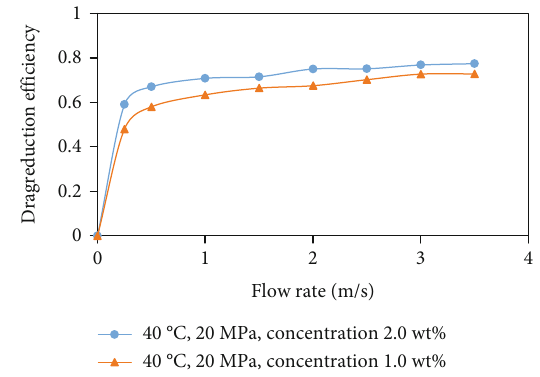
Figure 7: Flow rate versus drag reduction e ffi ciency at 40 ° C/20